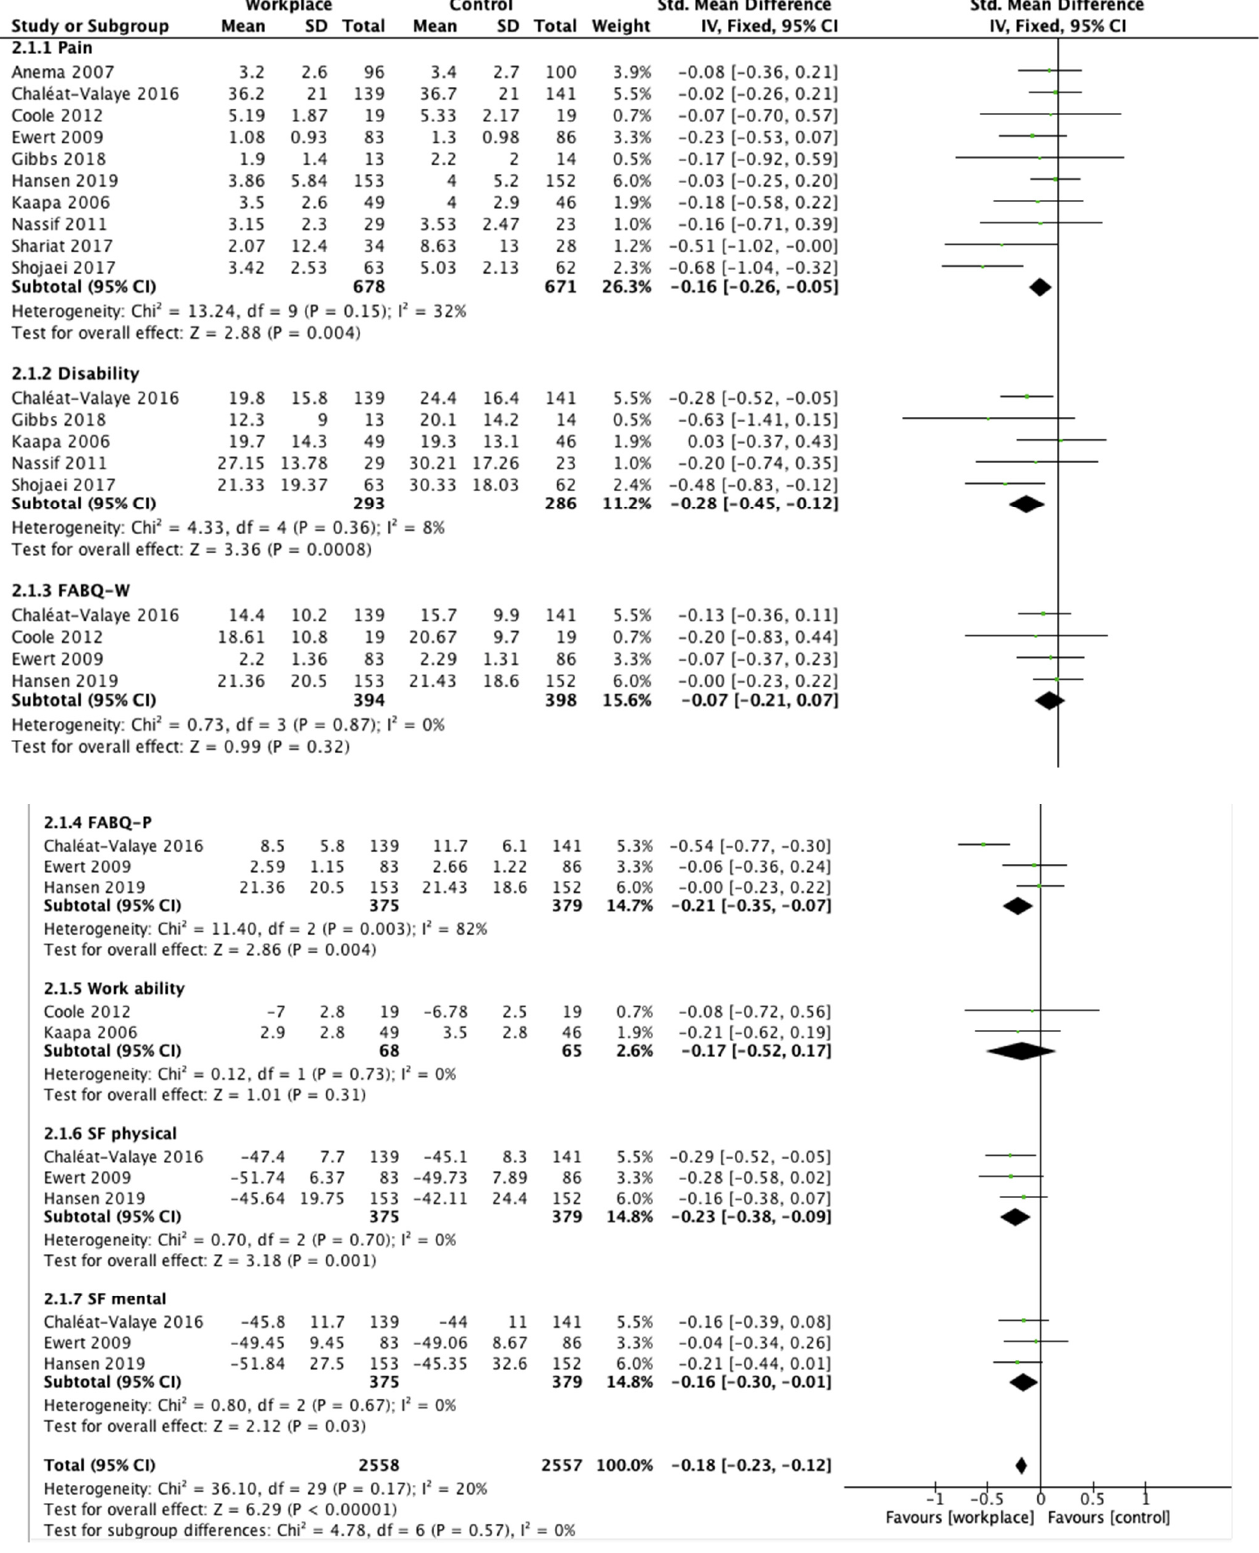
Figure 2. Outcome measurements.